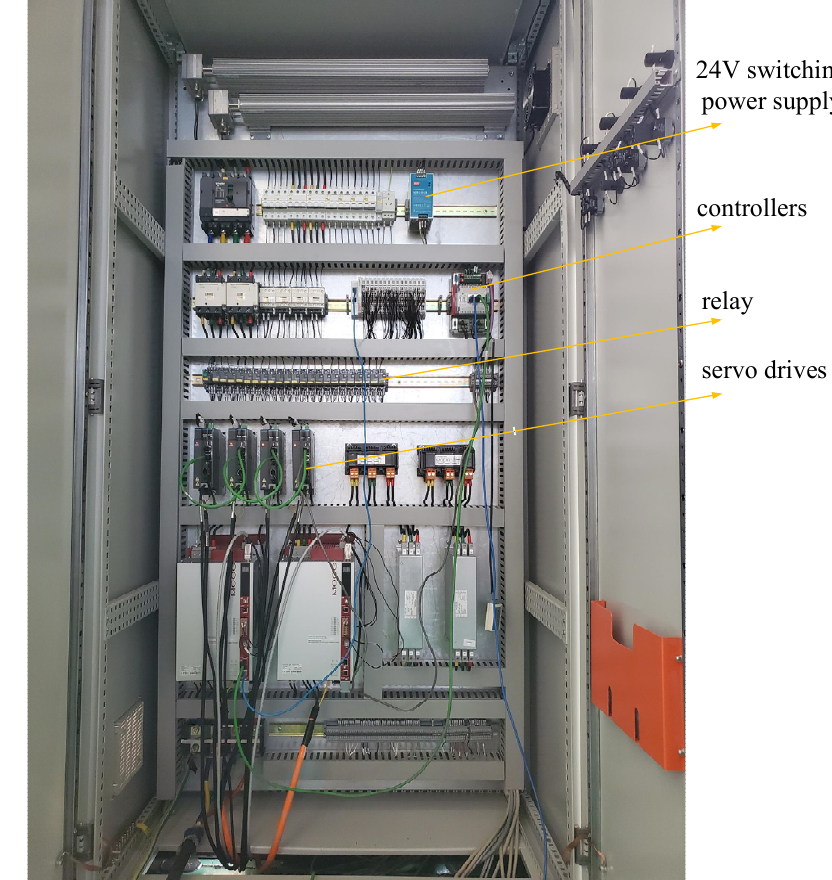
Processes 2021 , 9 , x FOR PEER REVIEW